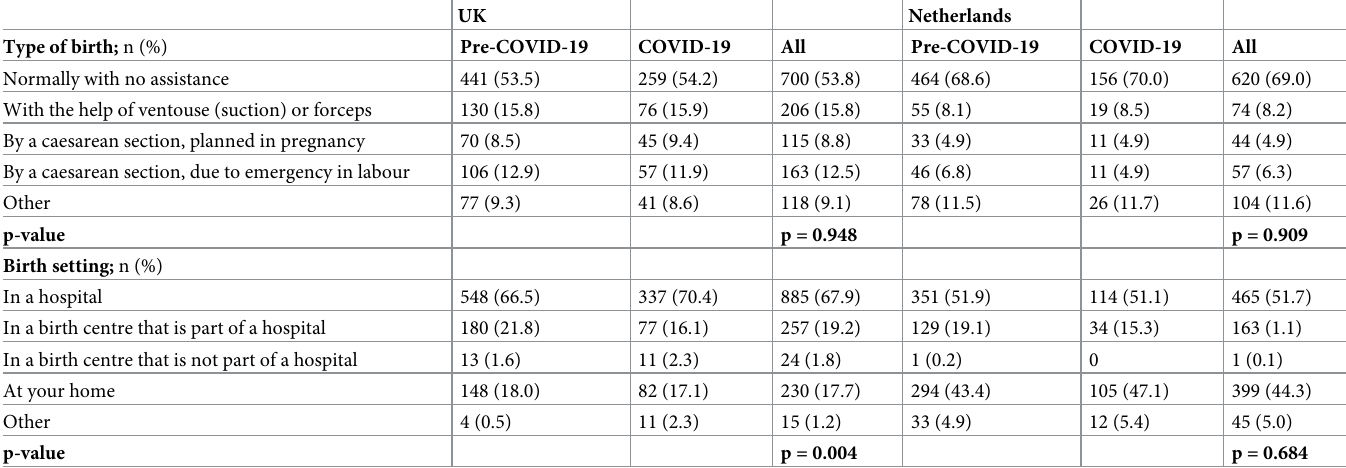
The NL had a higher percentage of women reporting a very good birth experience 65% (n = 581) compared to the UK 48% (n = 624), which is a statistically significant difference between the two countries (p-value < 0.01). No significant differences were found in either country for labour and birth experiences pre and during the COVID-19 pandemic for the respondents as a whole (Table 5). At both timepoints, and for those reporting all standards of life, reports of a positive experience were statistically significantly higher in the NL than in the UK. labour and birth experiences pre-COVID-19 64% (n = 233) compared to during the COVID- 19 pandemic (65%, n = 132). Women reporting a higher standard of life were non-significantly more likely to report better experiences if they gave birth during the pandemic than those who gave birth before COVID-19 (71% vs 65%). Table 4. Type of birth and birth setting of the included